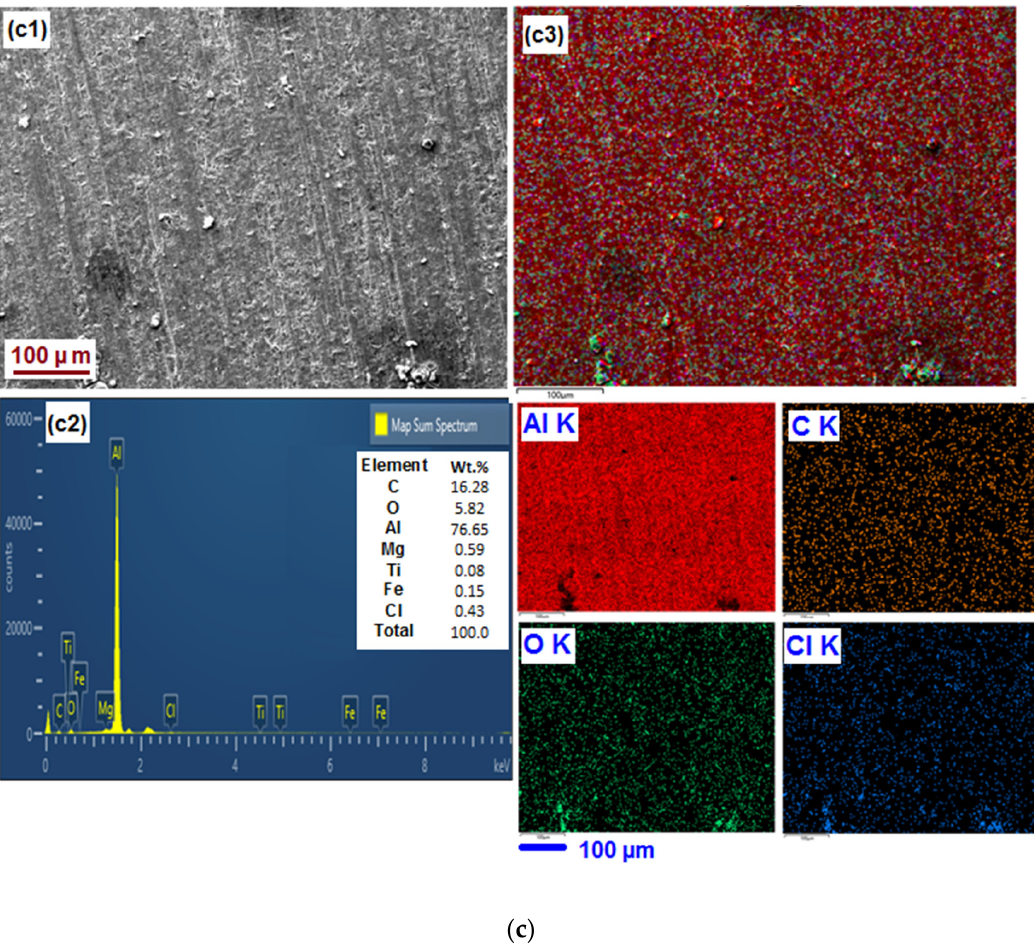
Figure 7. SEM micrograph and EDX images with their elemental mapping for different samples, ( a ) as polished; ( b1 – b3 ) after immersion in 1 M HCl in absence of inhibitor; ( c1 – c3 ) after immersion in 1 M HCl in presence of 3.0 mM inhibitor.